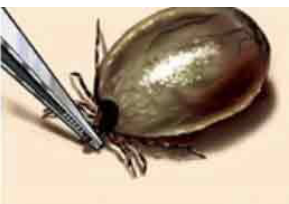
Figure 4. Tick removal using clamps